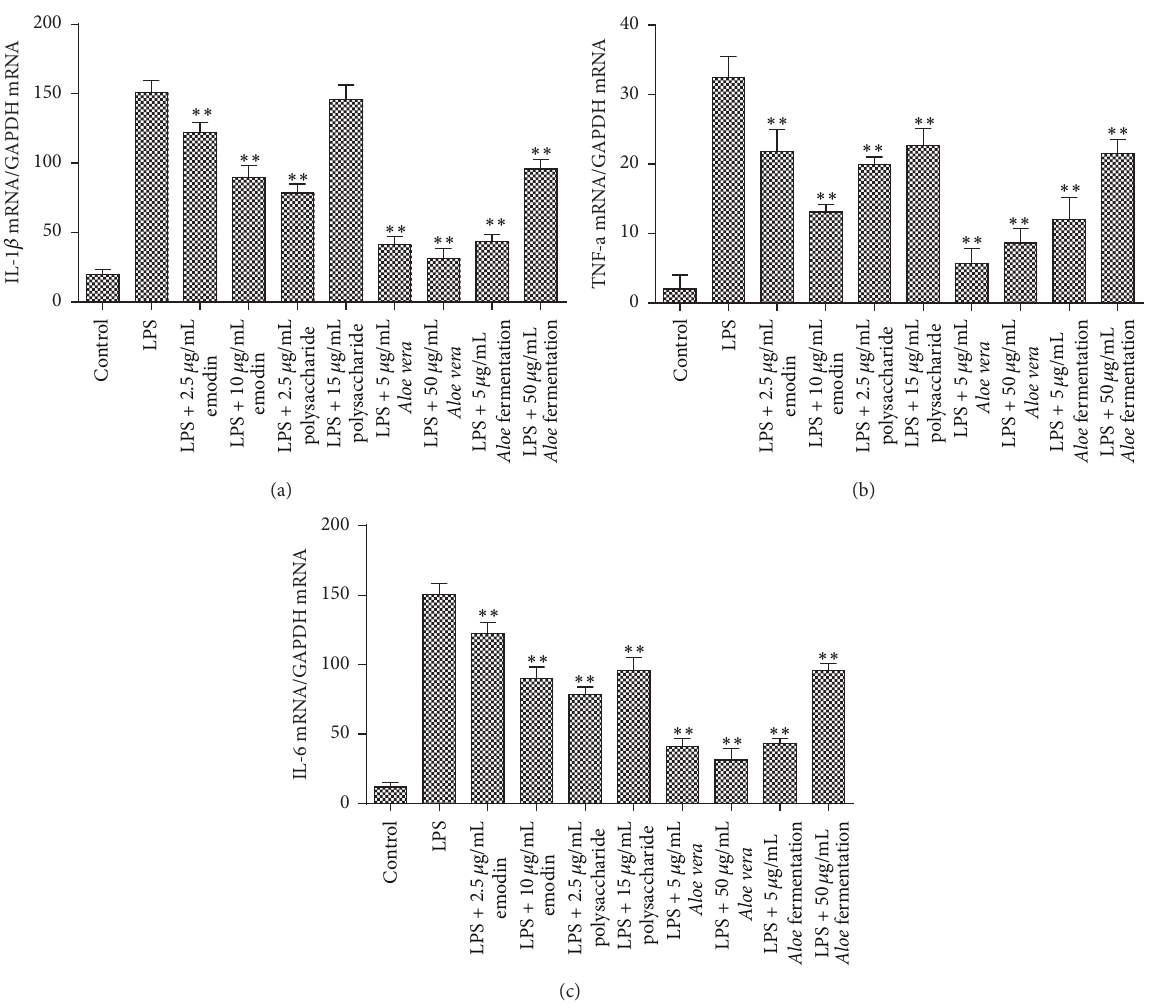
Figure 4: Effect of the different concentrations of emodin, polysaccharide, Aloe vera , and fermentation broth on the expression of inflammatory genes (IL-1 𝛽 , TNF- 𝛼 , and IL-6) in RAW 264.7 cells. Data are shown as the mean ± SD. ∗∗ 𝑃 < 0.01